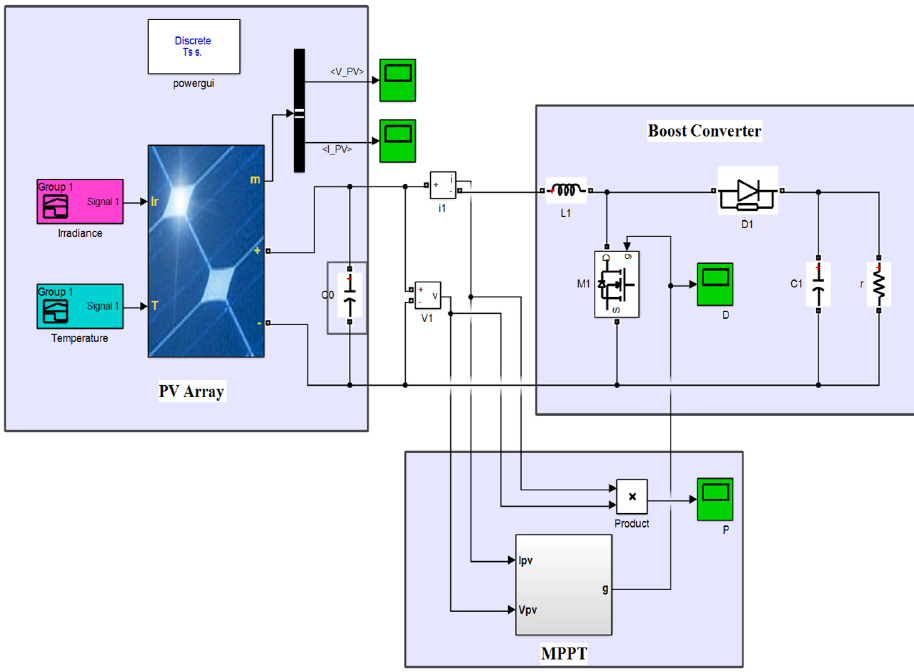
Figure 5. Block diagram for MPPT based on SSA method.